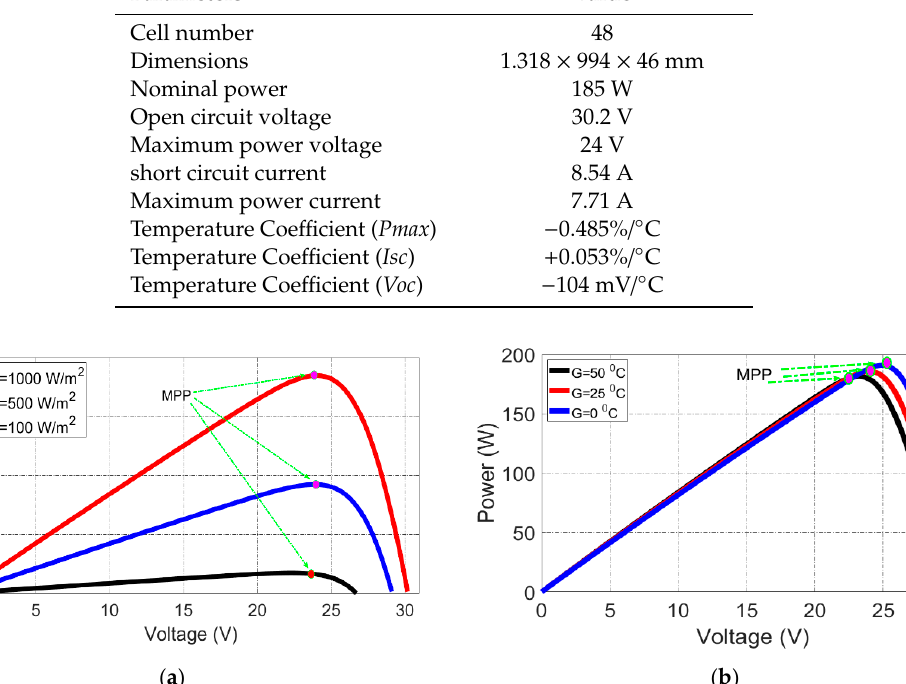
Figure 4. Power–voltage ( P–V) characteristic of a PV array under: ( a ) Different values of G at a constant T of 25 ° C; ( b ) different values of T at a constant G of 1000 W/m 2 .